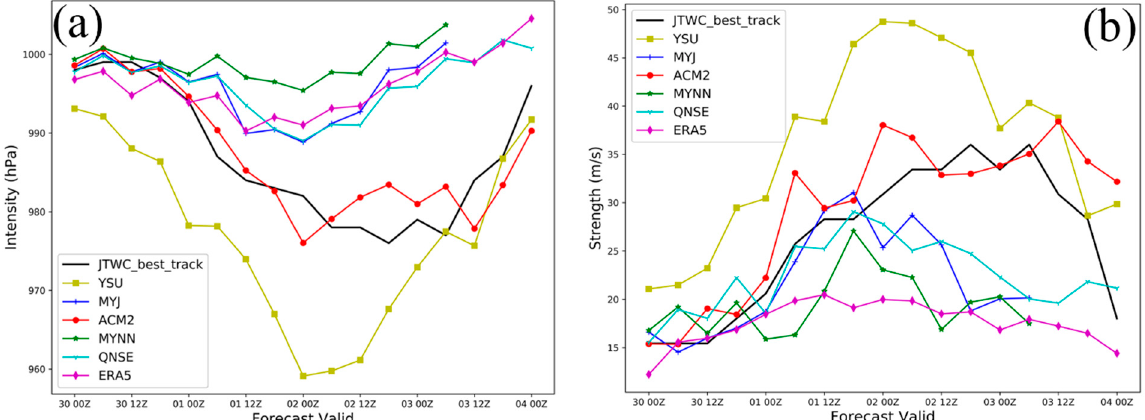
Figure 5. Time series of ( a ) intensity (hPa) and ( b ) strength (m/s) of Cyclone Shaheen by five PBL schemes, ERA5, and JTWC data. Table 2. Mean track error, MBE , and RMSE scores for intensity and strength with respect to three WRF experiments and ERA5. Boldface denotes best score among PBL